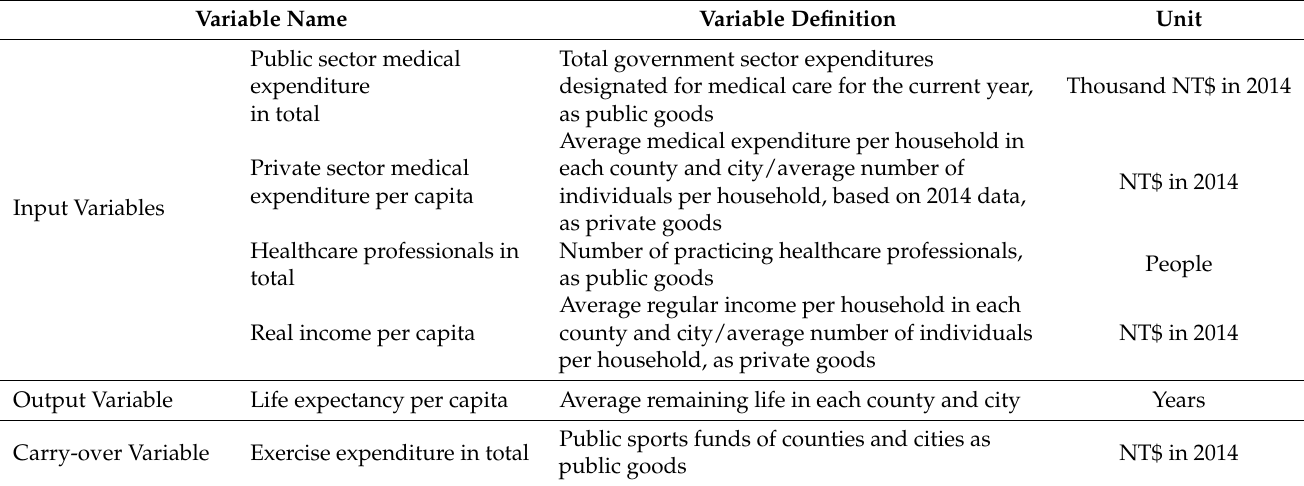
Table 1. Variable